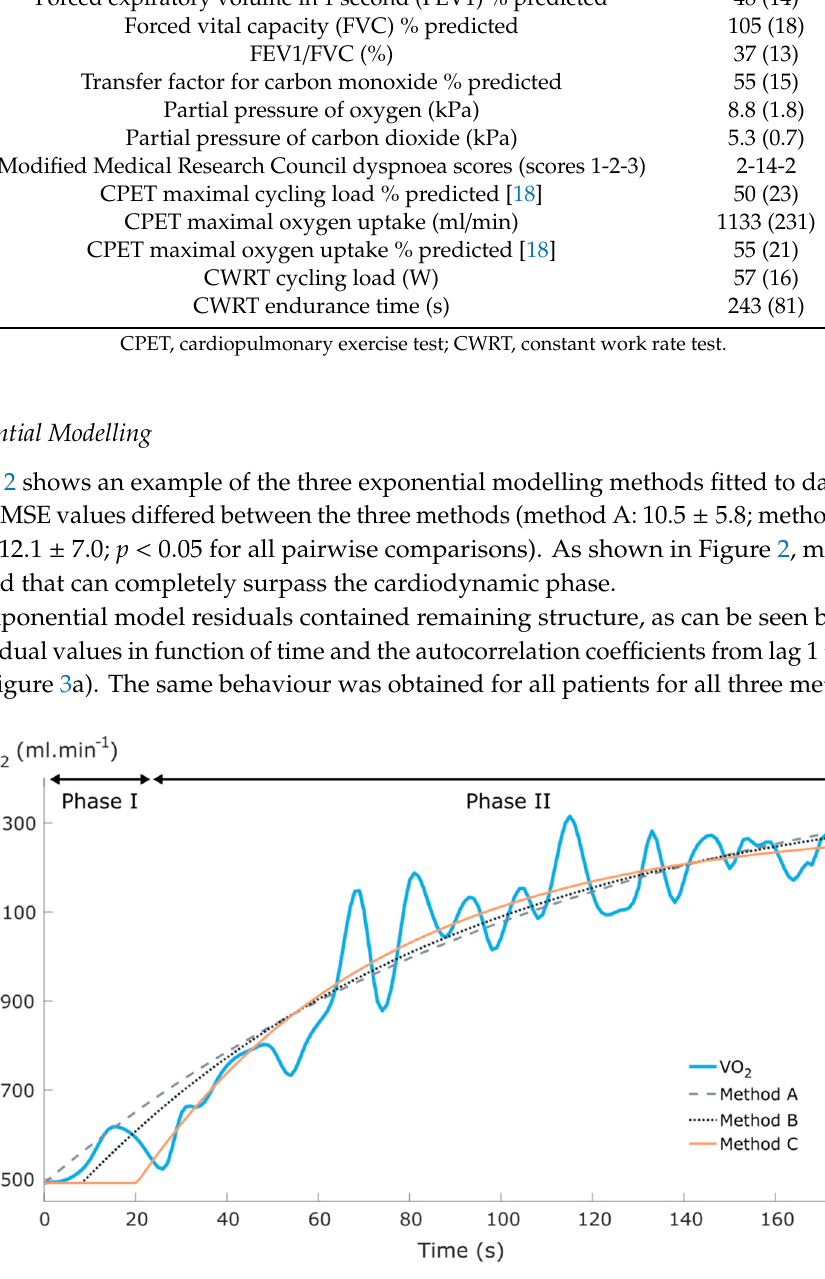
Figure 2. Example plot of VO 2 data and the three different exponential modelling methods. The estimated time delay (TD) values for methods B and C were 8.3 s and 20.3 s,